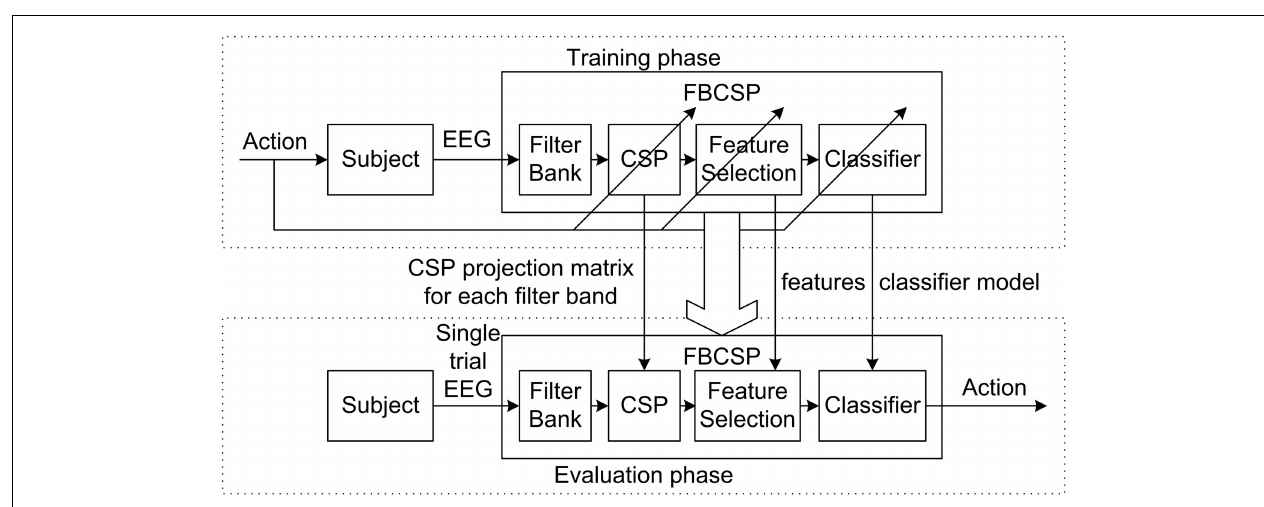
FIGURE 1 |Architecture of the filter bank common spatial pattern (FBCSP) algorithm for the training and evaluation phases.